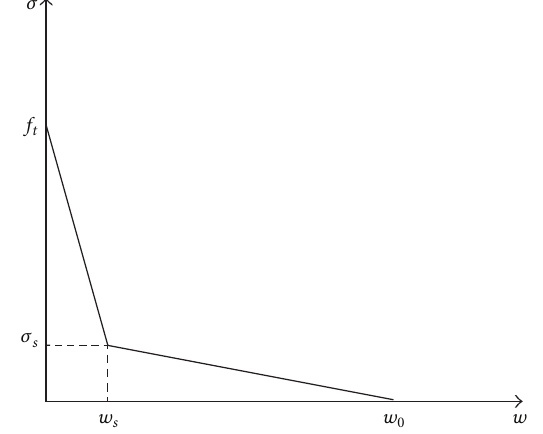
Figure 2: The bilinear softening traction-separation